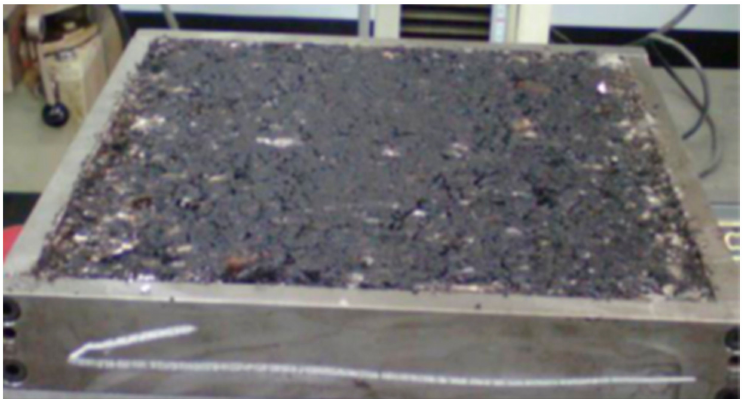
Figure 1. Rutting specimens for asphalt